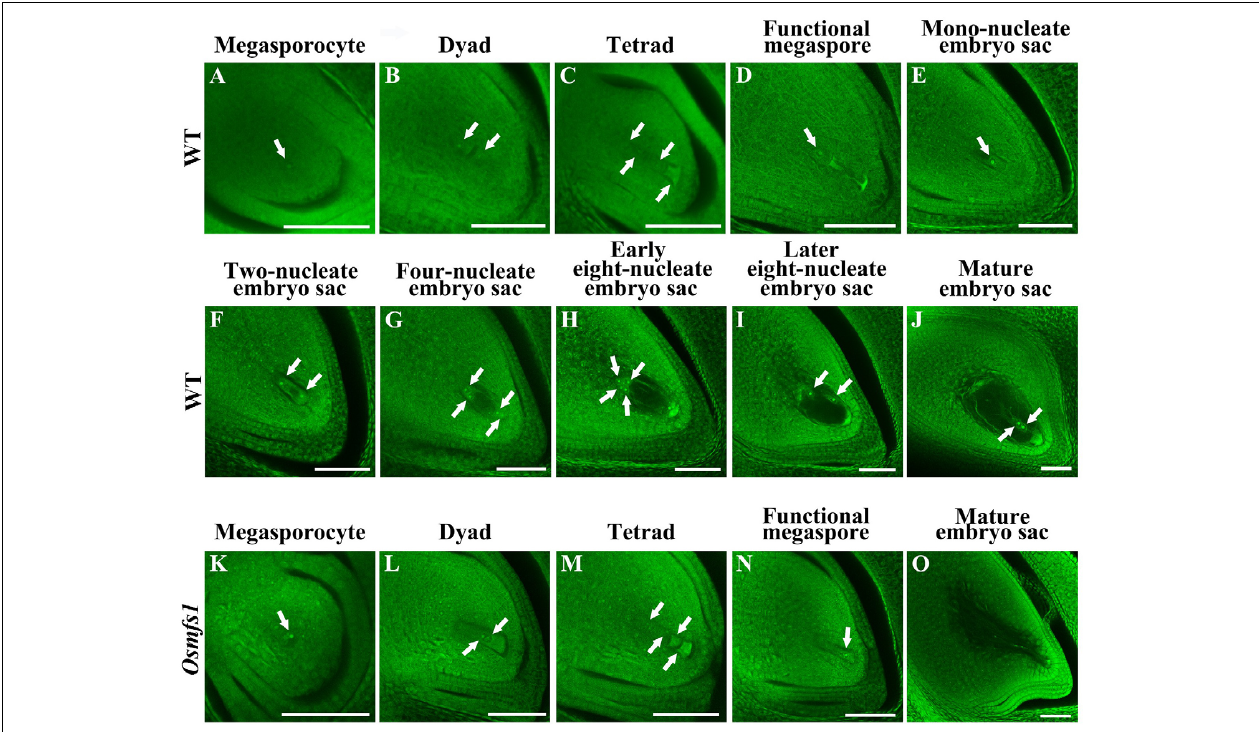
FIGURE 4 | Embryo sac development in the WT and the Osmfs1 mutant. (A–J) the WT, (K–O) the Osmfs1 , (A,K) Megasporocyte, (B,L) Dyad, (C,D) Tetrad, (D,N) Functional megaspore, (E) Mono-nucleate embryo sac, (F) Two-nucleate embryo sac, (G) Four-nucleate embryo sac, (H,I) Eight-nucleate embryo sac, (J,O) Mature embryo sac. The mature embryo sacs of the WT eventually formed viable egg cells when mutant showed hollow. Scale bar = 20 µ